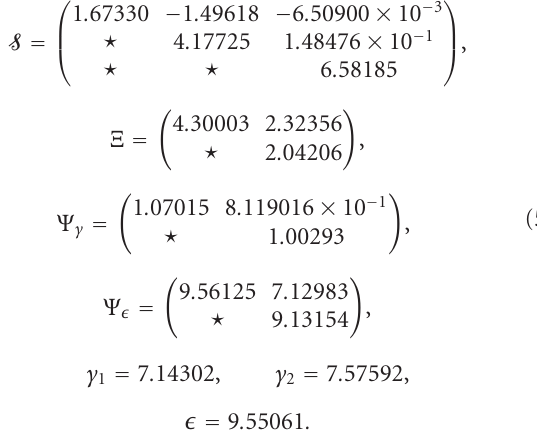
Figure 1: Time histories of the state variable x 1 ( t ).